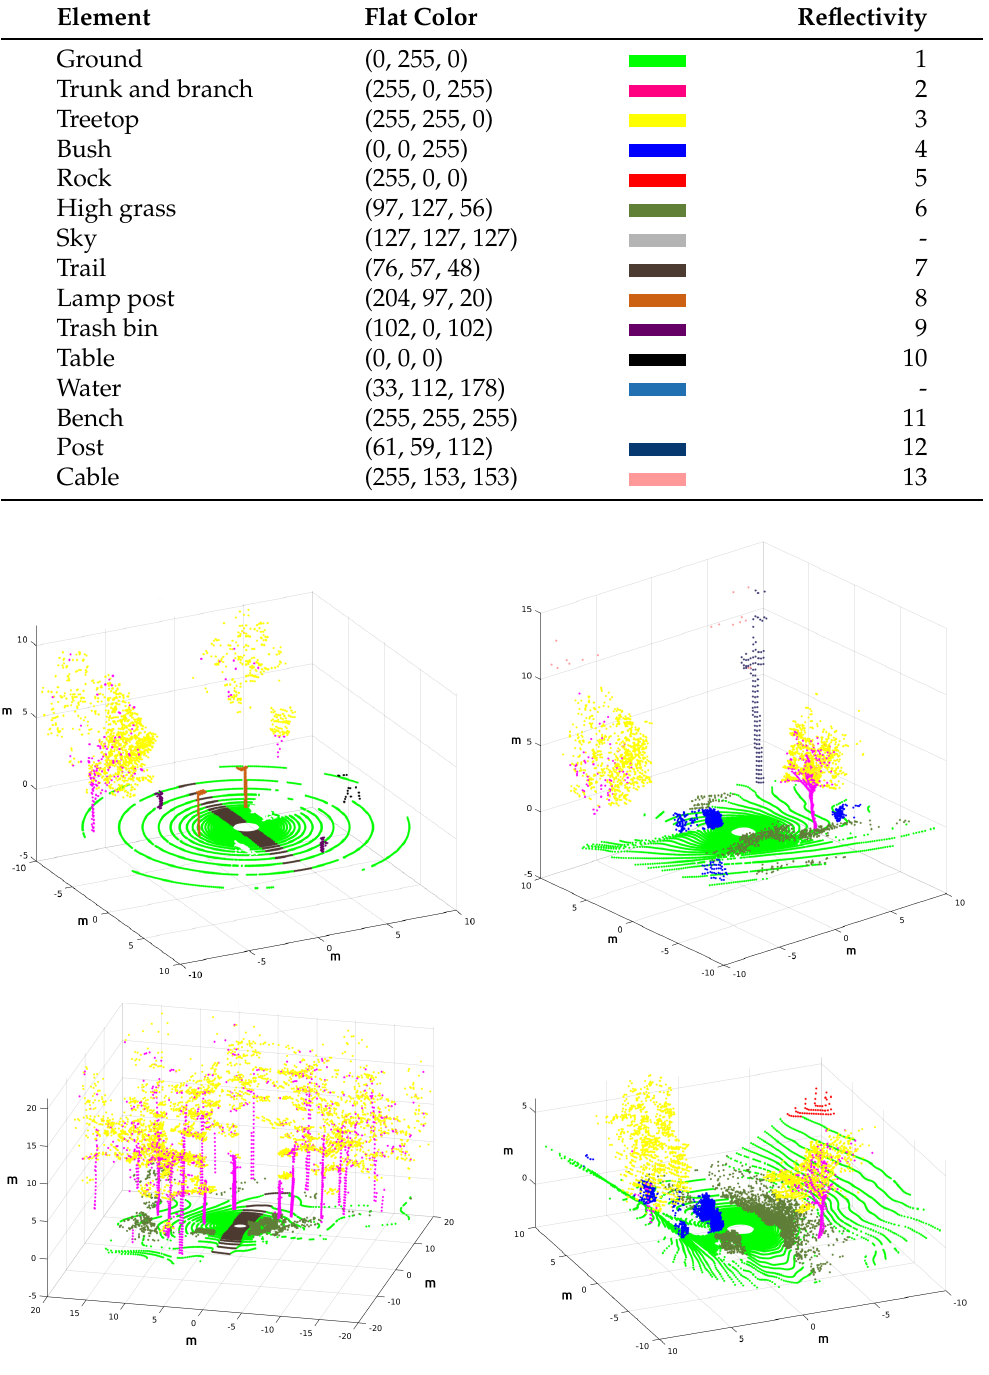
Figure 12. Annotated point clouds for the park ( up-left ), the lake ( up-right ), the forest ( left-down ) and the hill ( right-down ). Refer to Table 3 for element